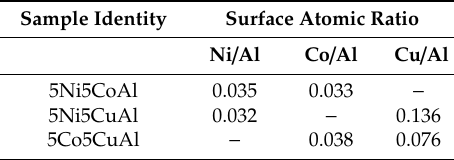
Table 2. Surface M / Al atomic ratios determined by XPS for the 5M5MAl catalyst samples. Table 2. Surface M/Al atomic ratios determined by XPS for the 5M5MAl catalyst samples.